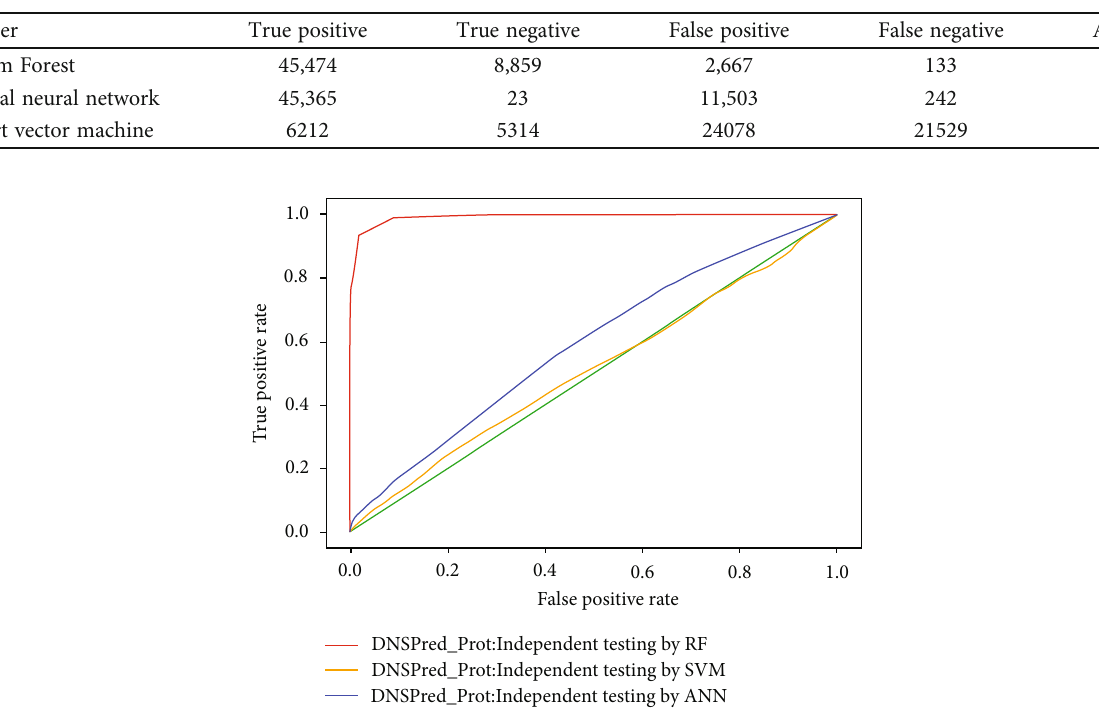
Figure 13: ROC comparison for